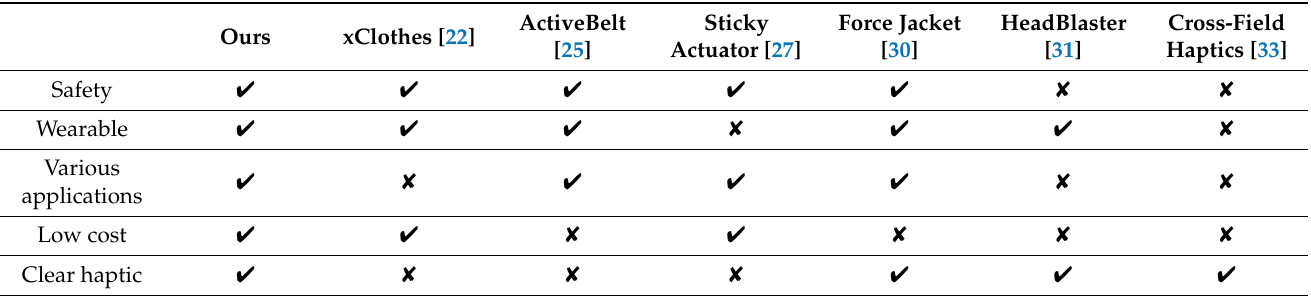
Table 1. Comparison of the proposed device with some of the related work introduced. It shows the similarities and differences between them.